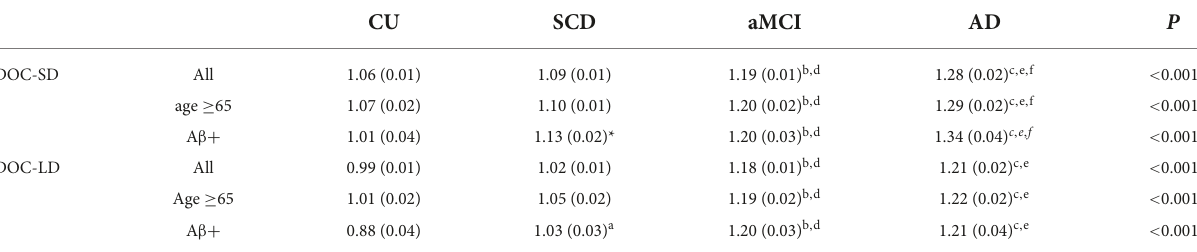
TABLE 1 Adjusted means (standard errors) of metamemory scores degree of confidence-short-term delay recall, long-term delay recall (DOC-SD, LD) adjusted for the influence of the covariates # . CU SCD aMCI AD